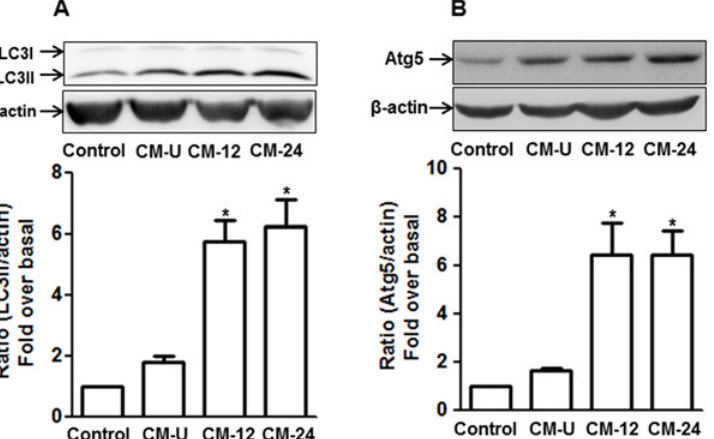
Fig 2. Paracrine effect of adiponectin on the expression of gene related to autophagy. Conditioned medium (CM) were prepared as described in materials and methods. After treatment with CM for 24 h, LC3II (A) and Atg5 (B) protein expression levels were determined by Western blot analysis. Images are representative of three independent experiments. Quantitative analyses of LC3II (A) and Atg5 (B) protein expression were performed by densitometric analysis and are shown in the graph (lower panel). Values are presented as mean ± SEM (n = 3). * P < 0.05 compared to control and CM-U. Control; Cells treated with DMEM containing 0.1% FBS, CM-U; CM prepared from gAcrp unstimulated cells, CM-12; Cells were stimulated with gAcrp for 8 h. After changing medium, cells were further incubated with 0.1% FBS/DMEM for 12 h without gAcrp and media was collected as CM-12, CM-24; Cells were stimulated with gAcrp for 8 h. After changing medium, cells were further incubated with 0.1% FBS/DMEM for 24 h without gAcrp and media was collected as